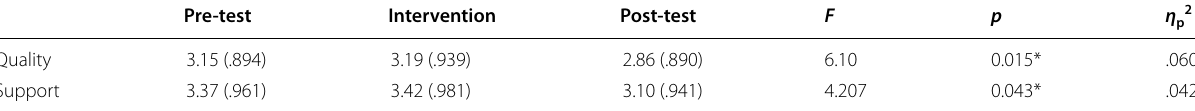
Linear contrasts with 1, 96 degrees of freedom, * p <